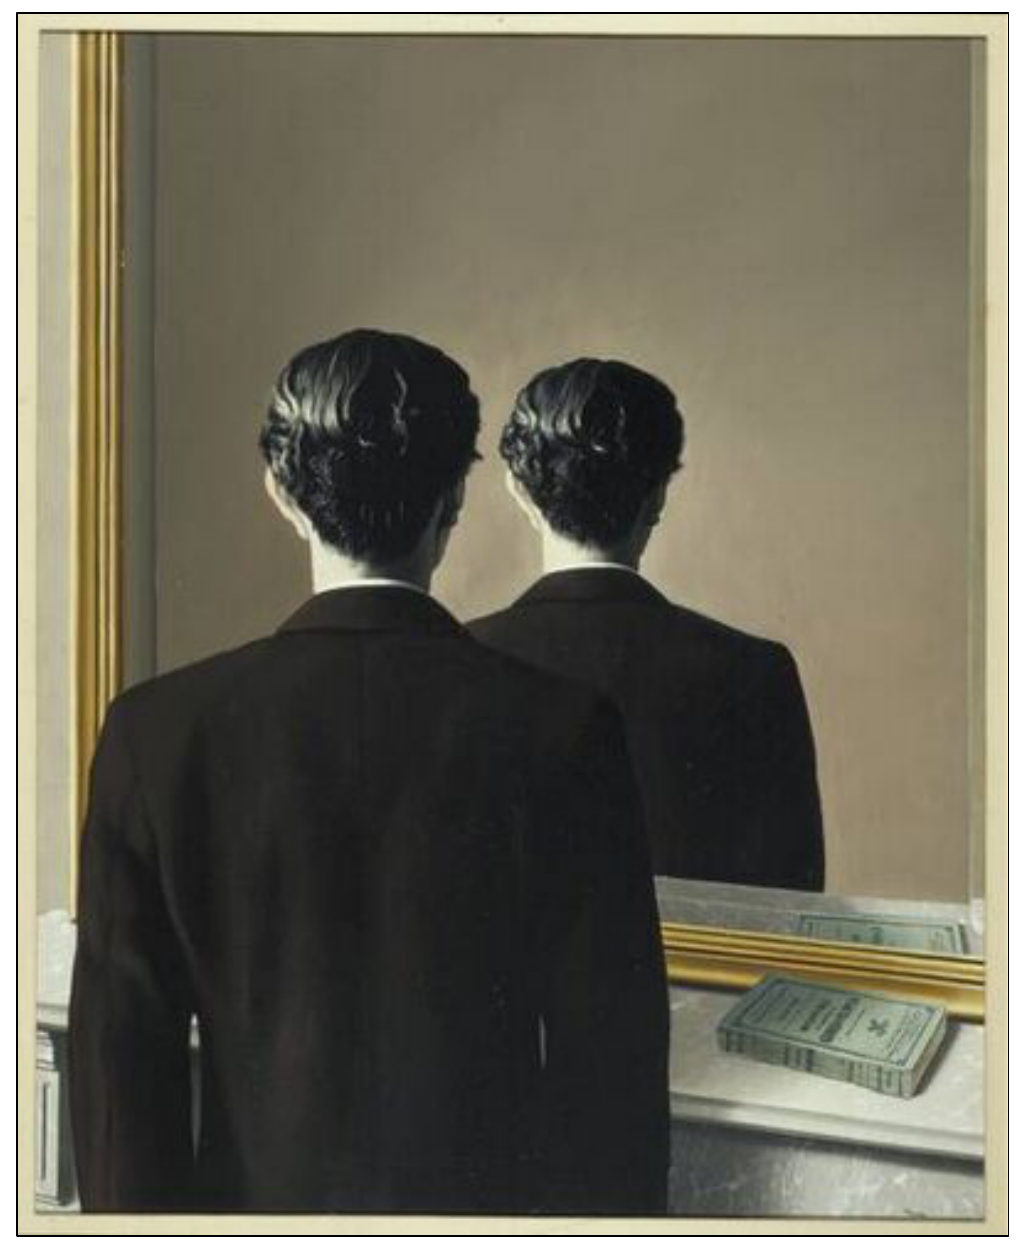
Figuur 4: Verboden af te beelden (Museum van Boimans Beuningen